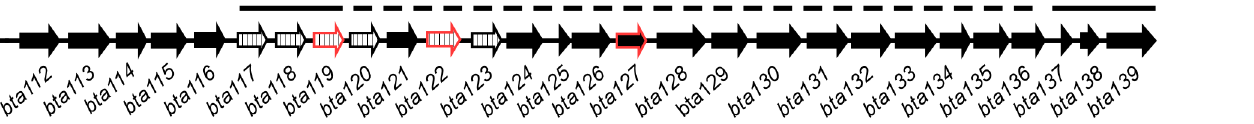
PLOS ONE | DOI:10.1371/journal.pone.0147707 February 4,